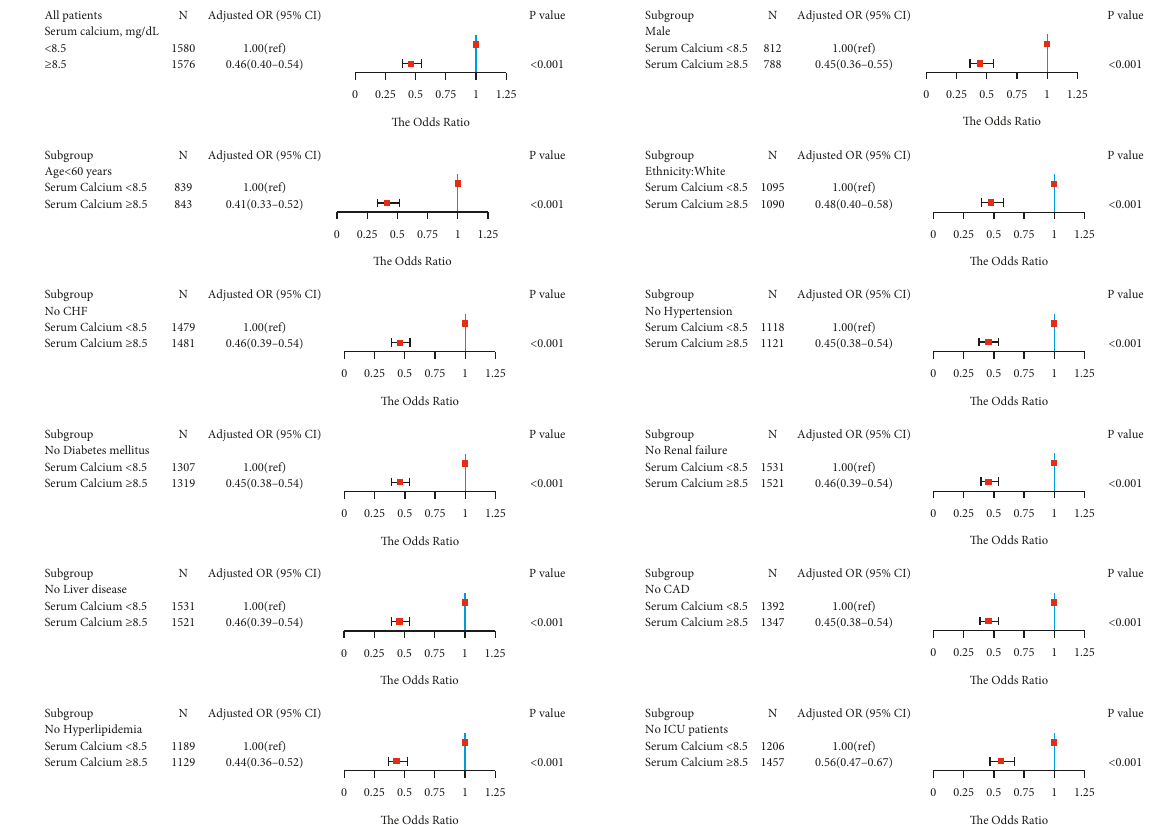
Figure 5: Results of subgroup analyses of the serum calcium level and a hospital length of stay (LOS) > 7 days according to clinical